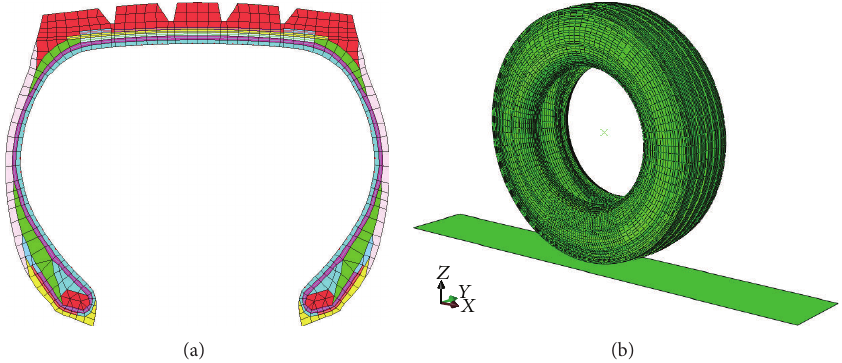
Figure 2: (a) Axisymmetric FEM model. (b) Three-dimensional FEM model.